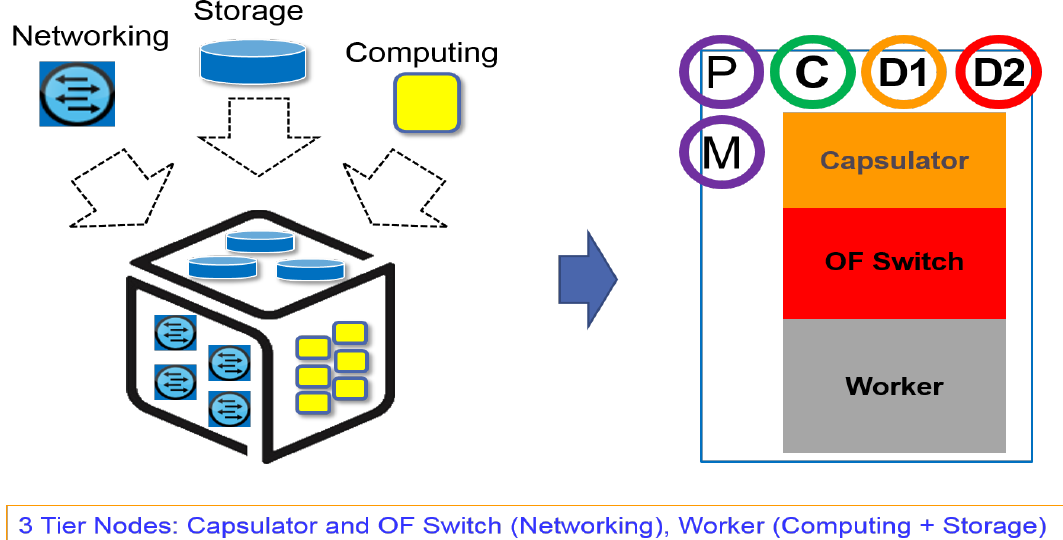
Figure 4. The concept of box-style hyper-converged